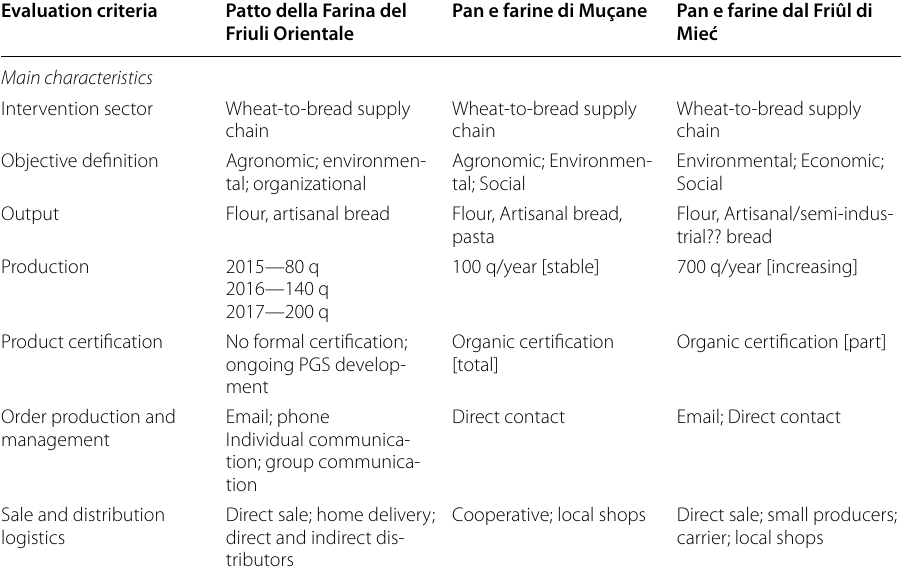
Table 1 Main characteristics WHAT Evaluation criteria